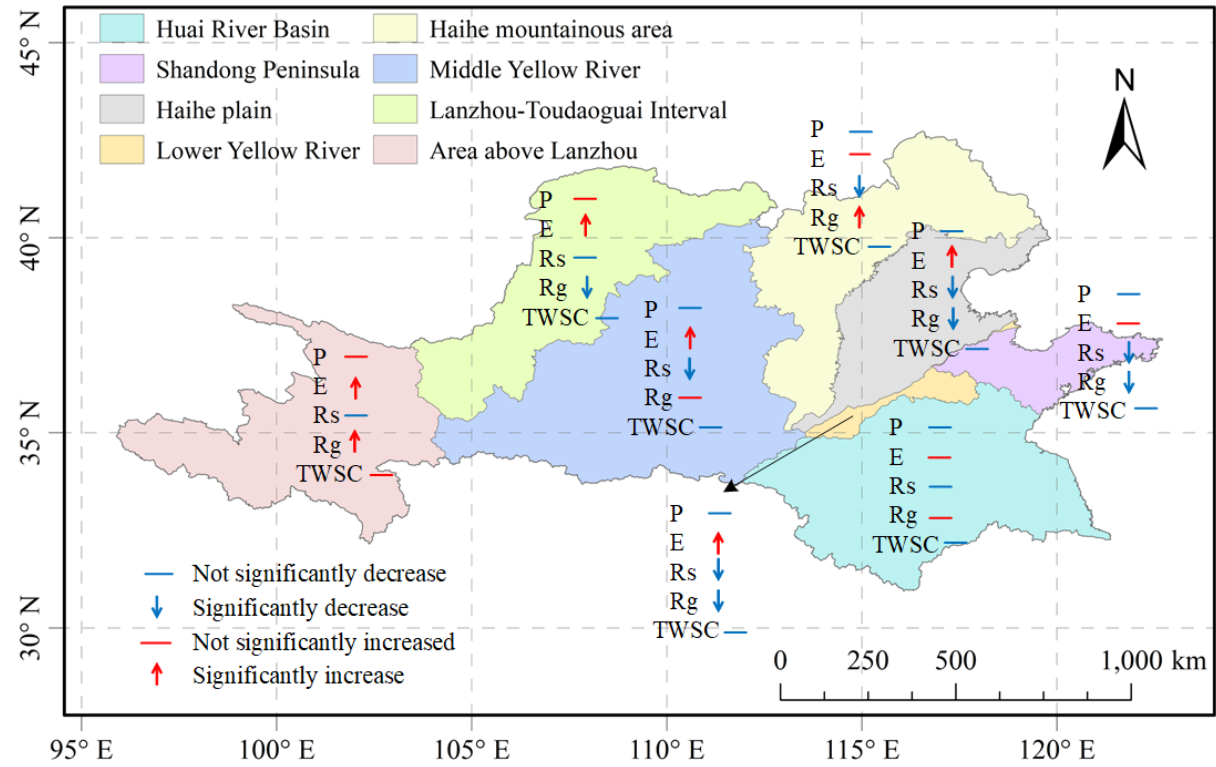
Figure 6. Temporal variation trend of water cycle elements in the HRB from 1956 to 2018.